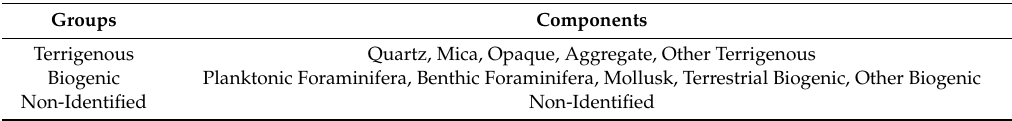
Table 1. Classification of sand sized